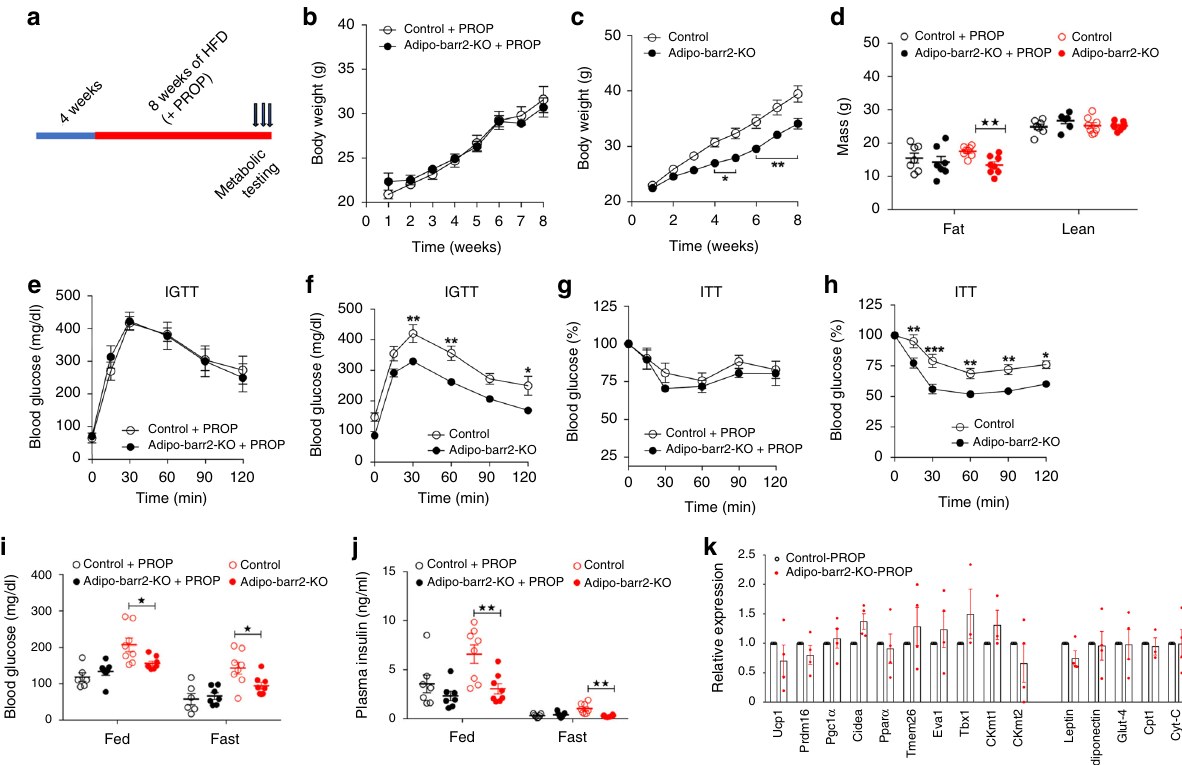
Fig. 5 In the presence of propranolol, HFD adipo-barr2-KO mice show no metabolic phenotypes. a Study design. When control and adipo-barr2-KO mice were 4 weeks old, they were maintained on a HFD at room temperature (23 °C) for at least 8 weeks. During HFD feeding, a subgroup of mice received drinking water containing propranolol (PROP) at 0.5 g/l. b , c Body weights during HFD feeding. In b , the drinking water was supplemented with PROP. In c , the mice received regular drinking water for control purposes ( n = 6 – 8/group). d Body composition of mice consuming HFD for 10 weeks with or without PROP treatment ( n = 6 – 8/group). e , f I.p. glucose tolerance test (1 g glucose/kg; IGTT) in PROP-treated ( e ) or untreated ( f ) mice after 8 weeks of HFD feeding ( n = 6 – 8/group). g , h I.p. insulin tolerance test (0.75 U insulin/kg i.p.; ITT) in PROP-treated ( g ) or untreated ( h ) mice after 9 weeks of HFD feeding ( n = 6 – 8/group). i , j Freely fed and fasting blood glucose ( i ) and plasma insulin ( j ) levels in PROP-treated or untreated mice after 8 – 9 weeks of HFD feeding ( n = 6 – 8/group). k Relative transcript levels of browning/beiging marker genes and other key metabolic genes determined by qRT-PCR analysis of iWAT RNA after 12 weeks of HFD feeding of PROP-treated mice ( n = 4 per group). Male mice were used for all studies. Date are shown as means ± s.e.m. * p < 0.05, ** p < 0.01, *** p < 0.001 ( b , c , e – h two-way ANOVA followed by Bonferroni ’ s post hoc test.; d , i , j two-tailed Student ’ s t